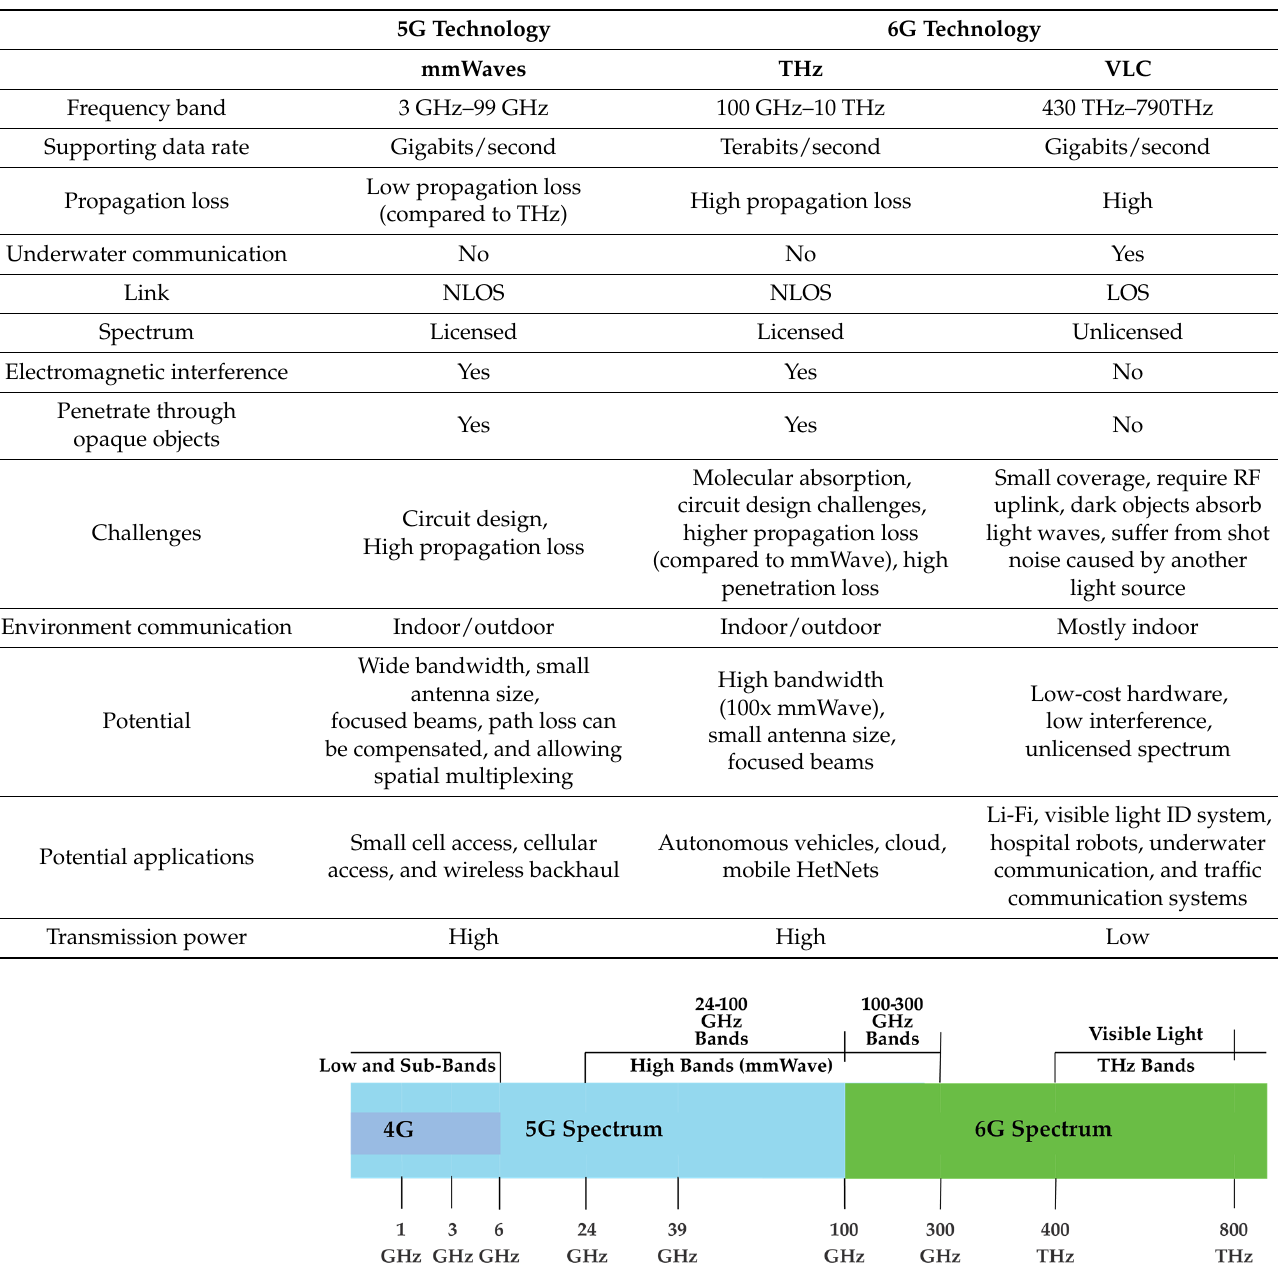
Figure 4. 4G, 5G, and 6G spectrum